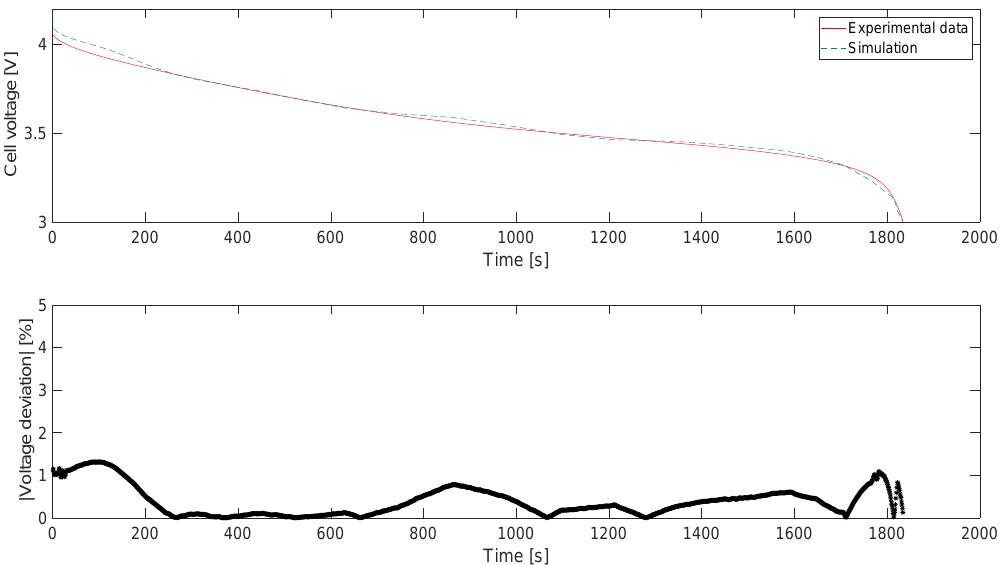
Figure 16. ( Upper ) Uncycled cell voltage during high constant current discharge at 25 ◦ C room temperature; ( Lower ) Absolute value of the voltage deviation between experimental and simulations data.